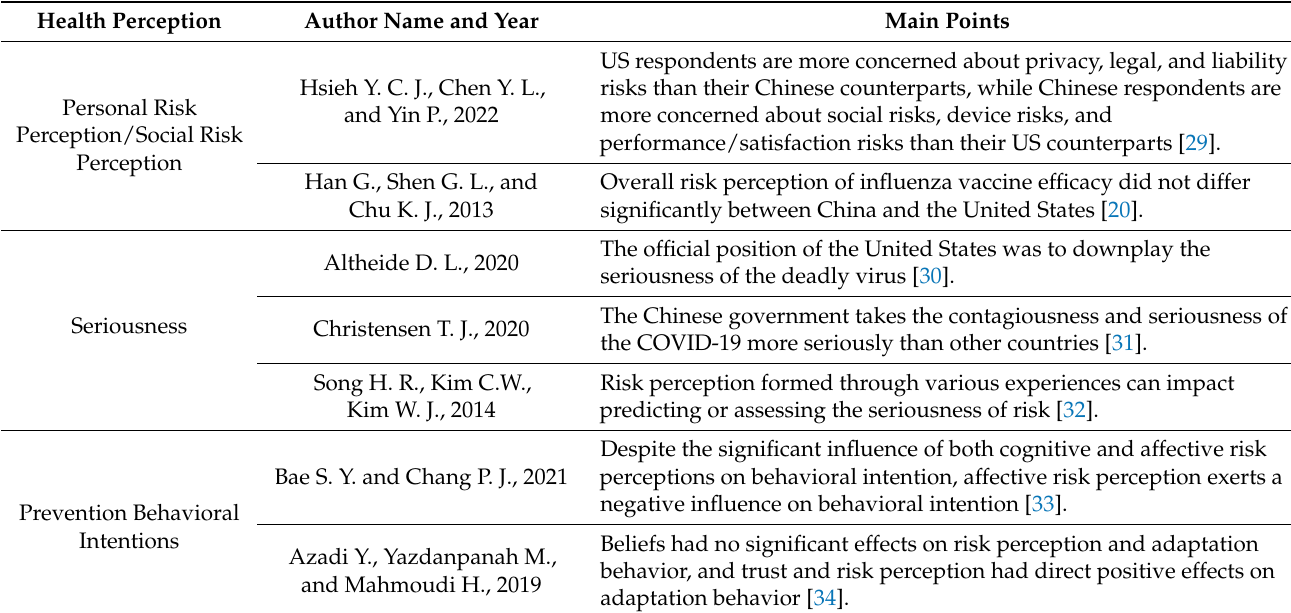
Table 2. A review of studies on health